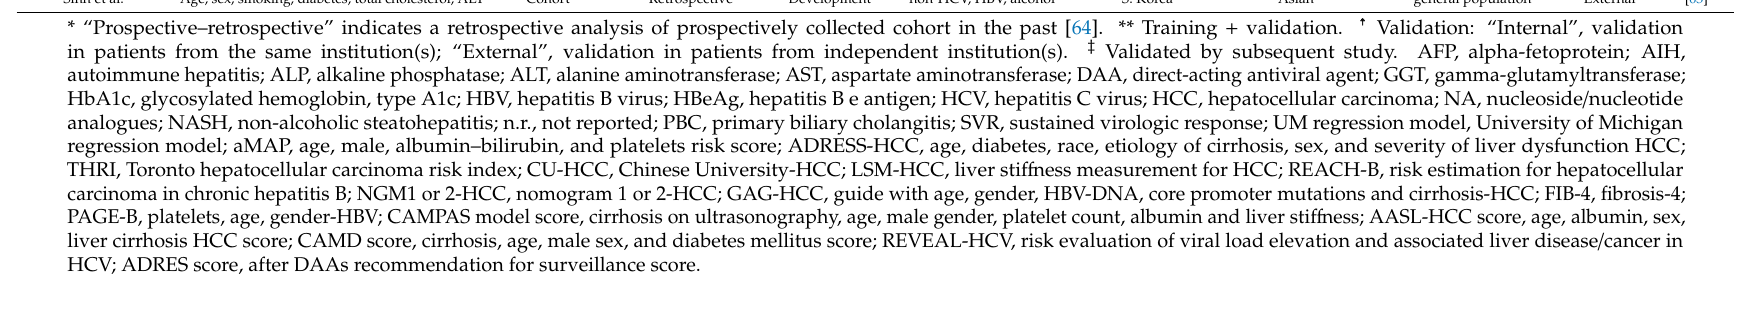
Table 1. Clinical HCC risk scores. Validation: “Internal”, validation in patients from the same institution(s); “External”, validation in patients from independent institution(s). ‡ Validated by subsequent study. AFP, alpha-fetoprotein; AIH, autoimmune hepatitis; ALP, alkaline phosphatase; ALT, alanine aminotransferase; AST, aspartate aminotransferase; DAA, direct-acting antiviral agent; GGT, gamma-glutamyltransferase; HbA1c, glycosylated hemoglobin, type A1c; HBV, hepatitis B virus; HBeAg, hepatitis B e antigen; HCV, hepatitis C virus; HCC, hepatocellular carcinoma; NA, nucleoside / nucleotide analogues; NASH, non-alcoholic steatohepatitis; n.r., not reported; PBC, primary biliary cholangitis; SVR, sustained virologic response; UM regression model, University of Michigan regression model; aMAP, age, male, albumin–bilirubin, and platelets risk score; ADRESS-HCC, age, diabetes, race, etiology of cirrhosis, sex, and severity of liver dysfunction HCC; THRI, Toronto hepatocellular carcinoma risk index; CU-HCC, Chinese University-HCC; LSM-HCC, liver sti ff ness measurement for HCC; REACH-B, risk estimation for hepatocellular carcinoma in chronic hepatitis B; NGM1 or 2-HCC, nomogram 1 or 2-HCC; GAG-HCC, guide with age, gender, HBV-DNA, core promoter mutations and cirrhosis-HCC; FIB-4, fibrosis-4; PAGE-B, platelets, age, gender-HBV; CAMPAS model score, cirrhosis on ultrasonography, age, male gender, platelet count, albumin and liver sti ff ness; AASL-HCC score, age, albumin, sex, liver cirrhosis HCC score; CAMD score, cirrhosis, age, male sex, and diabetes mellitus score; REVEAL-HCV, risk evaluation of viral load elevation and associated liver disease / cancer in HCV; ADRES score, after DAAs recommendation for surveillance